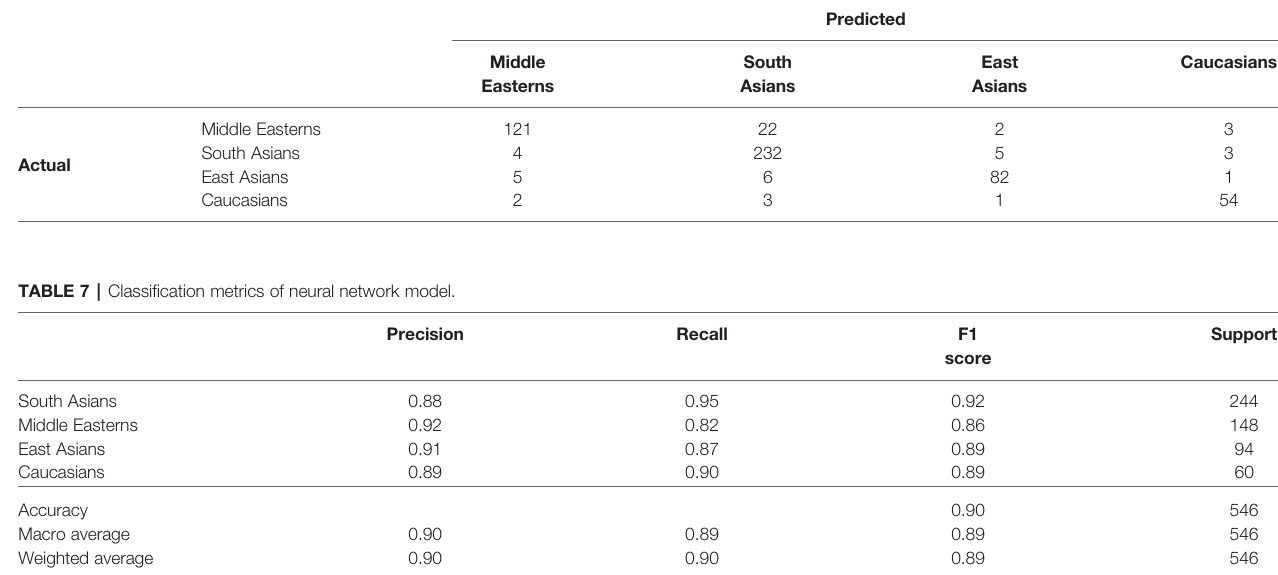
TABLE 6 | Confusion matrix to assess accuracy of prediction with three-layer dense NN model classifying cases by ethnic group.